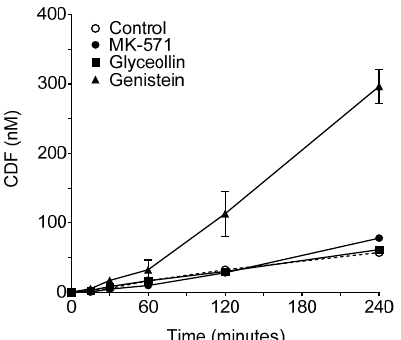
Figure 3. Hydrolysis of CDFDA by Caco-2 Cells. CDF concentration as a function of time following incubation with 5 µ M CDFDA for up to 4 h in the absence (control, dashed line) or presence of 100 µ M of MK-571, glyceollin or genistein. N = 3 for each condition. Specific activities based on initial rate conditions were 6.0, 6.2, 8.5 and 32.7 nM/min/mg protein for control, glyceollin, MK-571 and genistein, respectively.